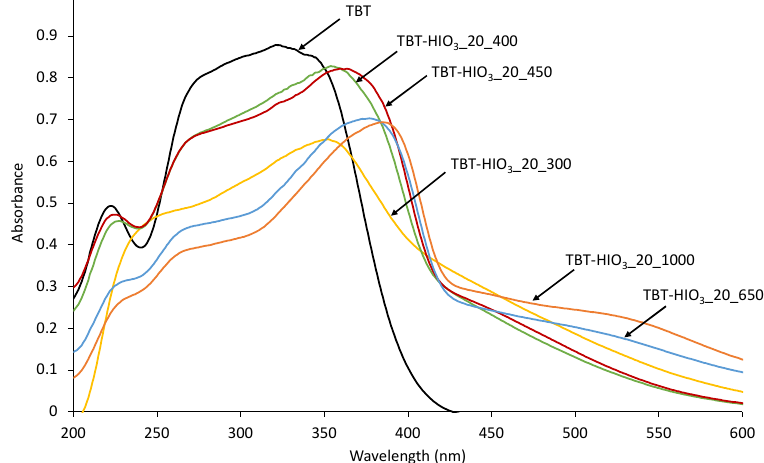
Figure 17. UV-Vis diffuse spectra for pure TiO 2 and defective TiO 2 -HIO 3 _20_T photocatalysts calcined in different temperatures.